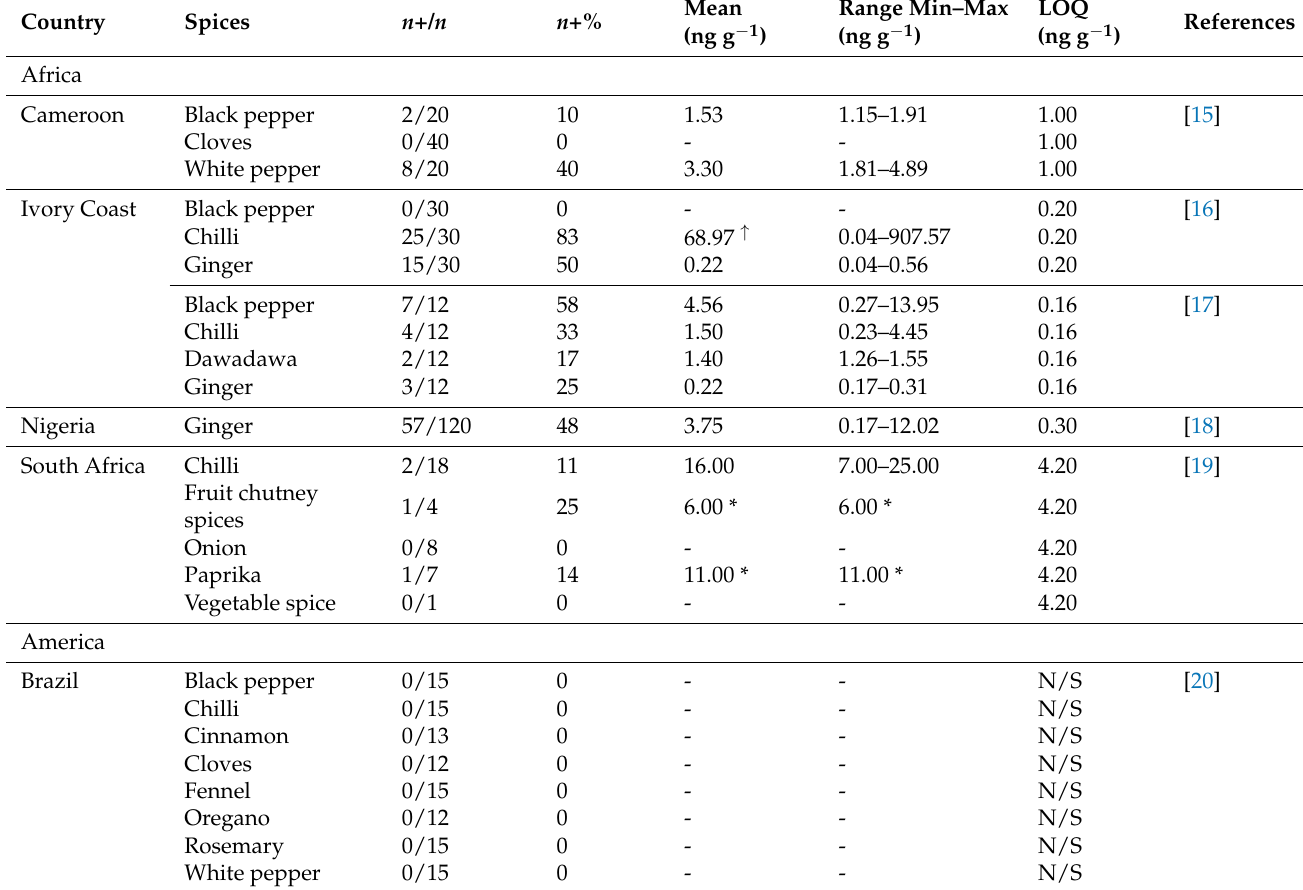
Table 1. Overview of studies dealing with the contamination of spices with OTA from a global